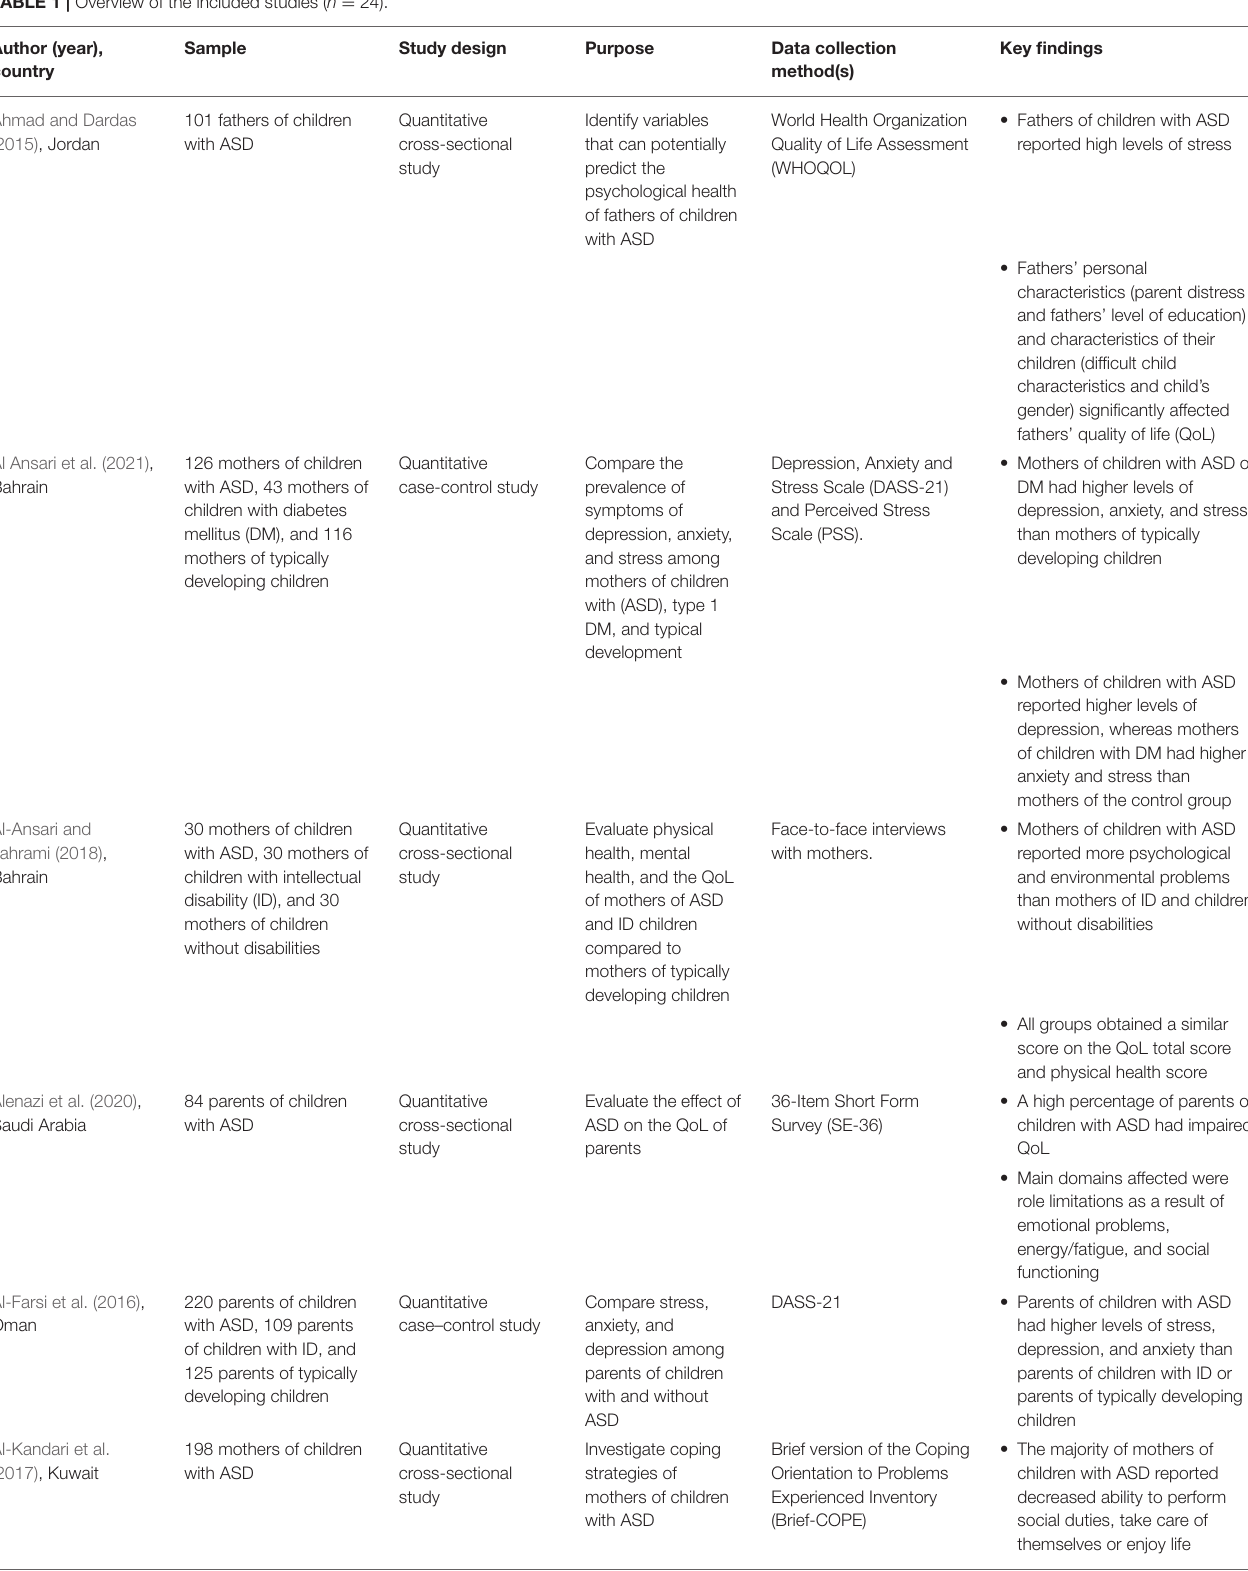
TABLE 1 | Overview of the included studies ( n =